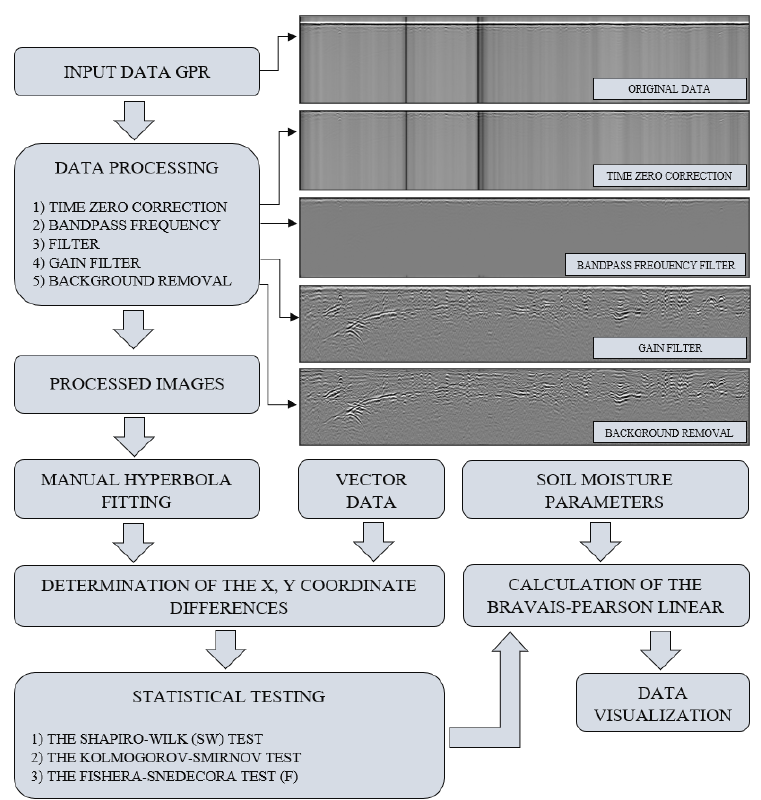
Figure 4. Diagram showing the stages of research work.